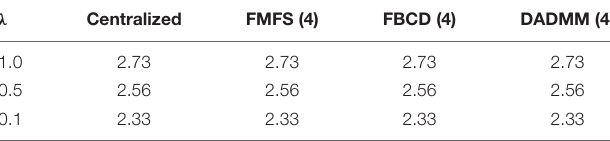
TABLE 6 | Average RMSE for predicting MMSE with FMFS across datasets from different institutions.